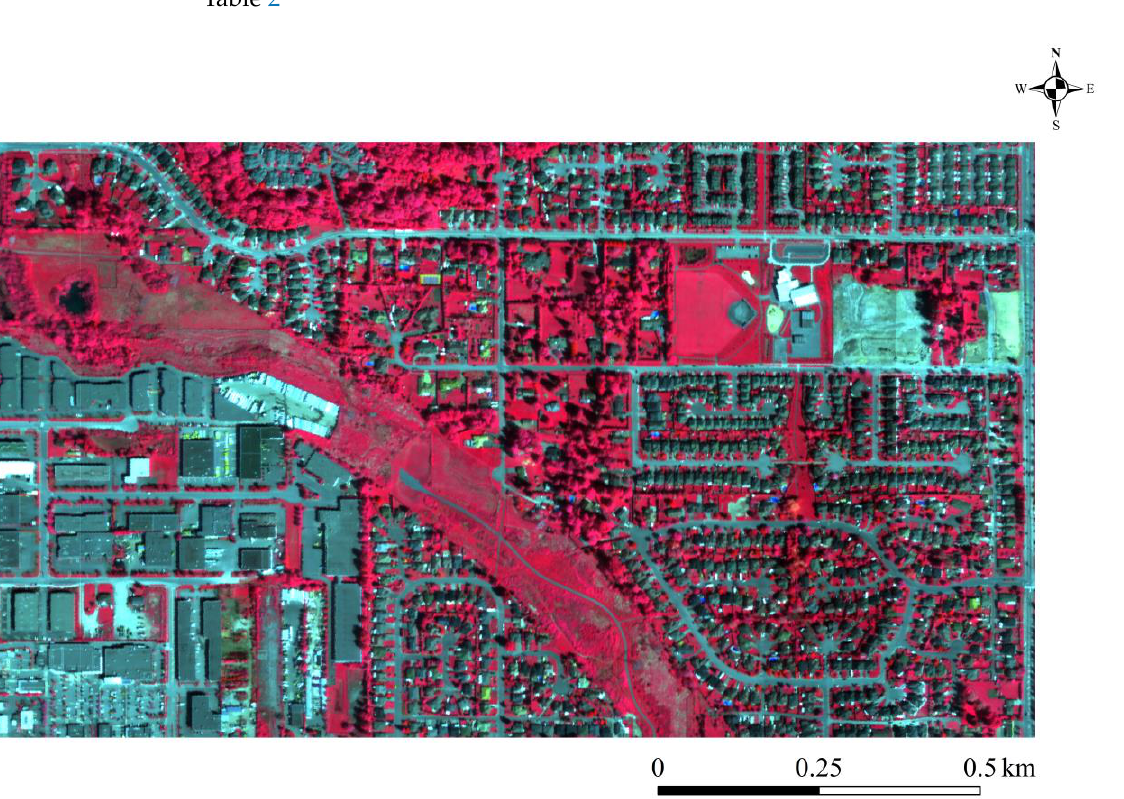
Table 1. Summary of training and validation samples of Houston dataset.